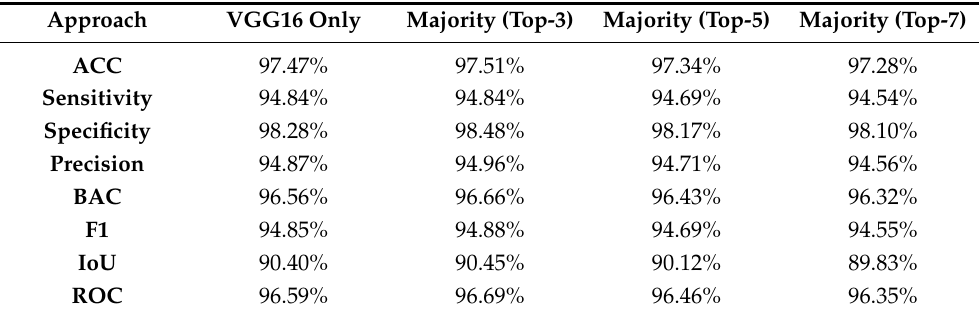
Table 9. The reported results concerning the “Monkeypox Images Dataset (MPID)” from VGG16 and after applying majority voting using k ∈ [ 3,5,7 ]